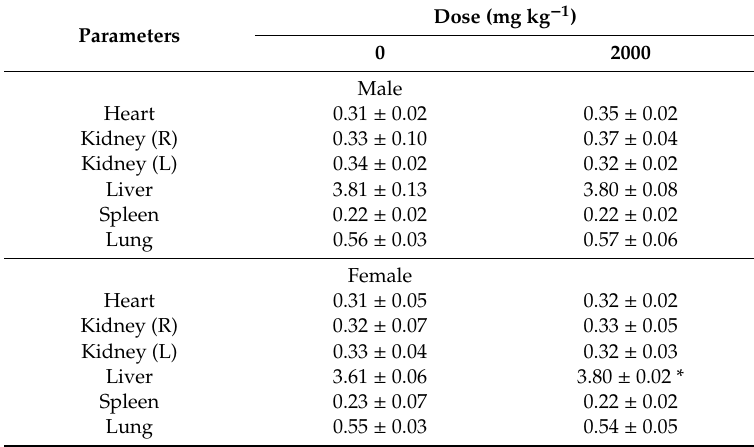
Table 2. Relative rat organ weights after treatment with palm puree during a 14 d acute toxicology study. Data are means ± SD for groups of five animals / sex / dose. * ( p < 0.05) vs. control group.